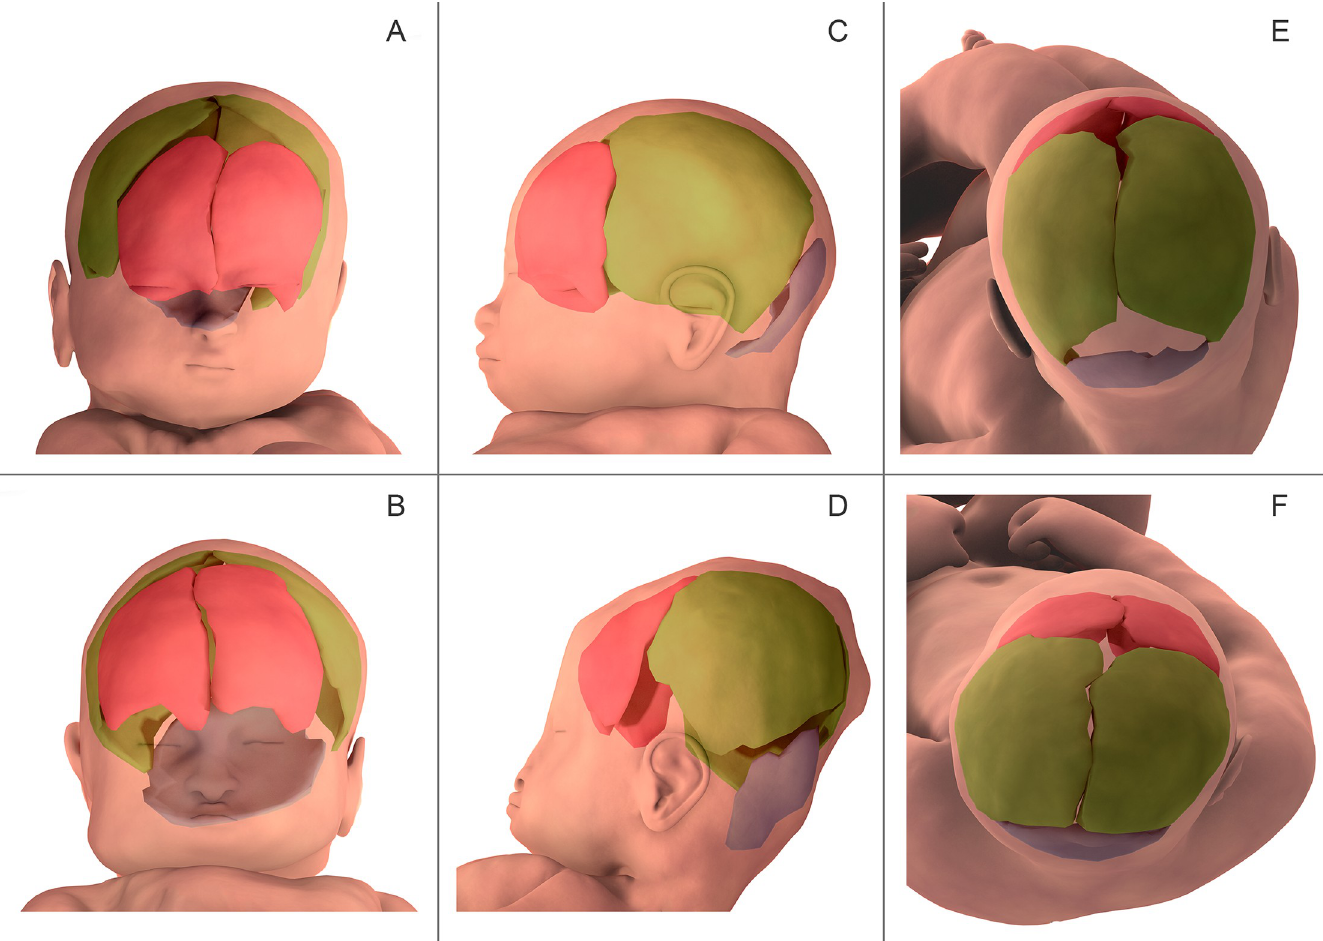
Fig 4. Three-dimensional finite element reconstruction of the cranial bones before labor (A, C, E) and during the second stage of labor (B, D, F) in patient 5 . Frontal bones are marked in pink, parietal bones in green, and the occipital bone in blue. In the anterior view (A, B) the bregmatic fontanelle was observed to decrease in size during delivery. In the lateral view (C, D) the skull bones were shown to change in relative orientation and amount of overlap. On the superior view (E,F) the bregmatic and lambdoid fontanels were seen to decrease in size during delivery.